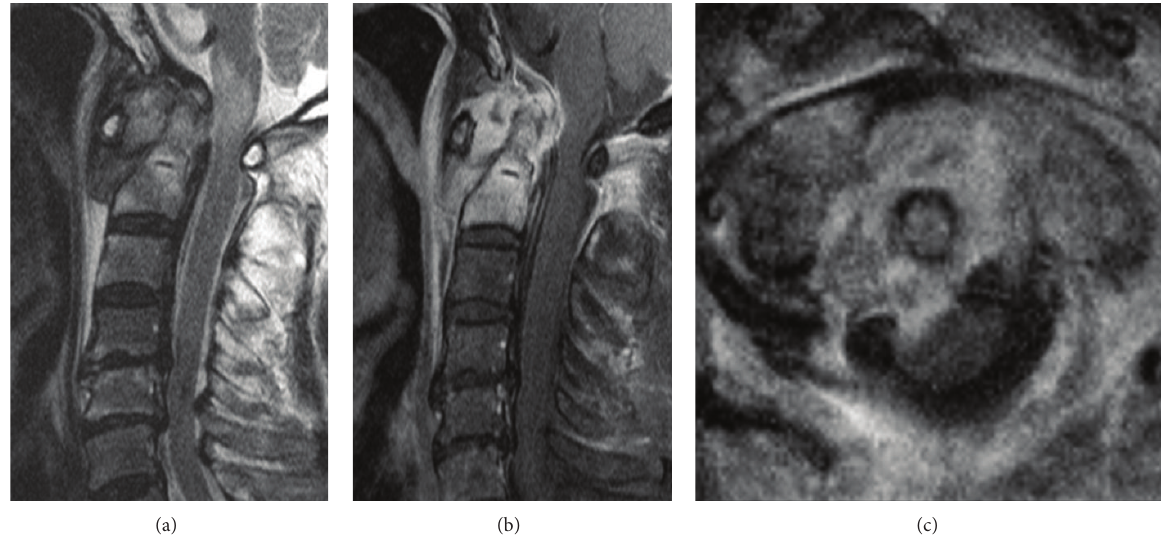
Figure 2: Magnetic resonance image showing abscess around the odontoid process. (a) Sagittal T2-weighted image. (b) Sagittal T1-weighted image with gadolinium. (c) Coronal T1-weighted image with gadolinium.